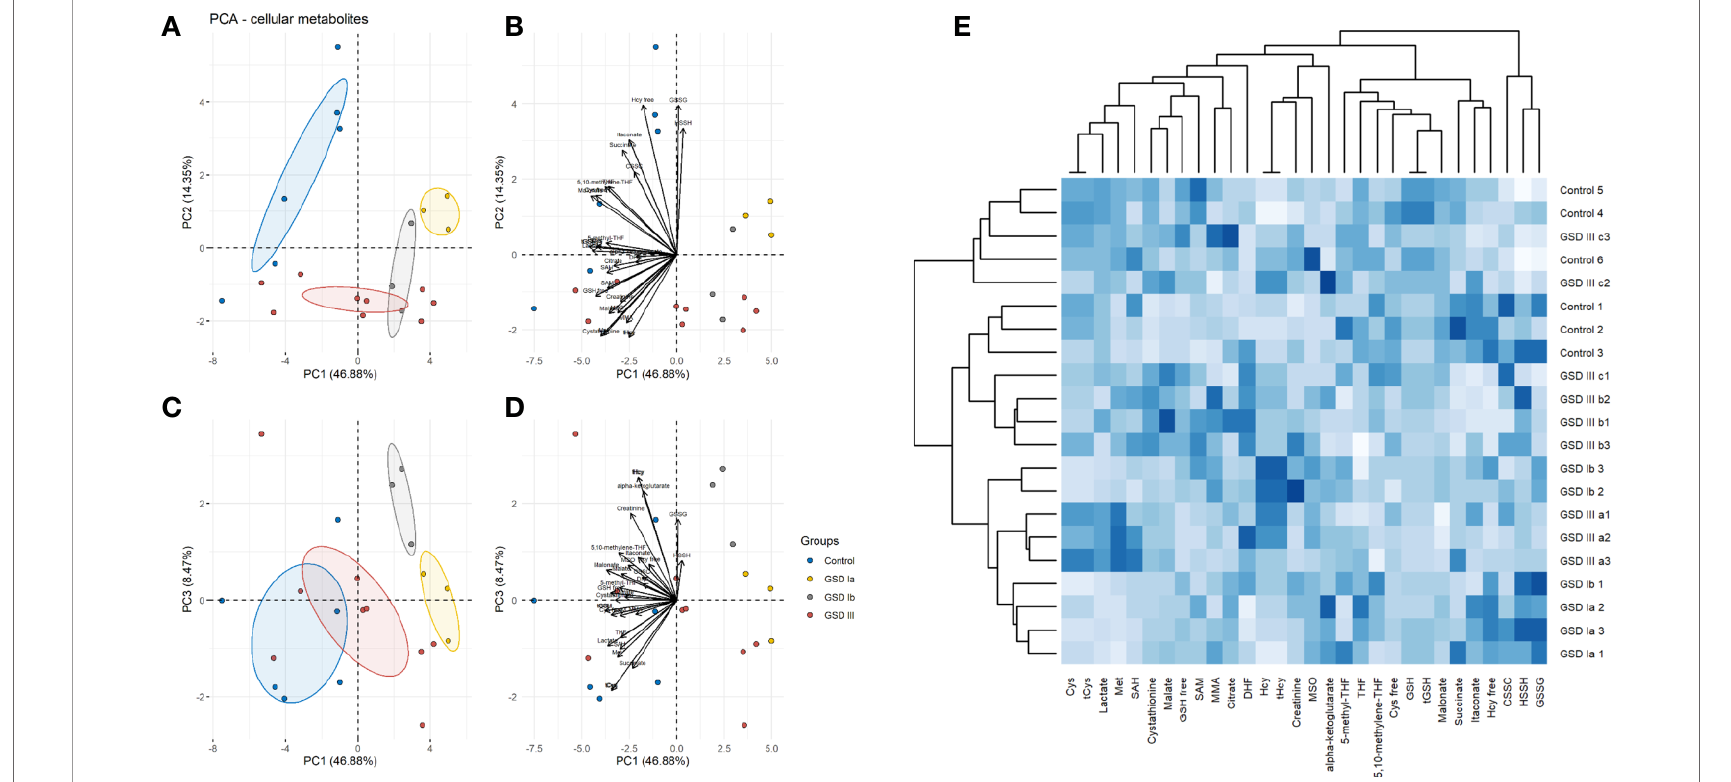
FIGURE 4 | Principal component analysis (PCA) of intracellular metabolites. Panel (A) Score plots of PC1-PC2. Panel (B) Loading plots of PC1-PC2. Panel (C) Score plots of PC1 – PC3. Panel (D) Loading plots of PC1-PC3. Control: n=3; GSDIa n =1; GSDIb n=1; GSDIII n=3, each by triplicate. A total of 31 metabolites were included in the analysis. Ellipses shown at 95% con fi dence centered around the mean of data points. The small overlap among ellipses depicts differences between healthy controls and disease subtypes. Panel (E) Heatmap of intracellular metabolites with hierarchical clustering (Euclidean distance, complete